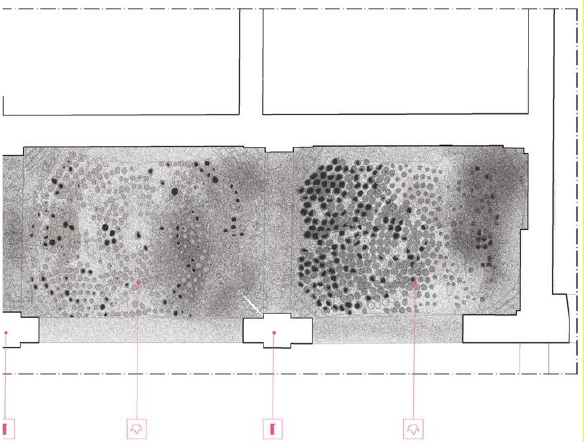
Figure 8. Conservation status of Masseria San Lorenzo : vaults with mummarelle located in the porch of first